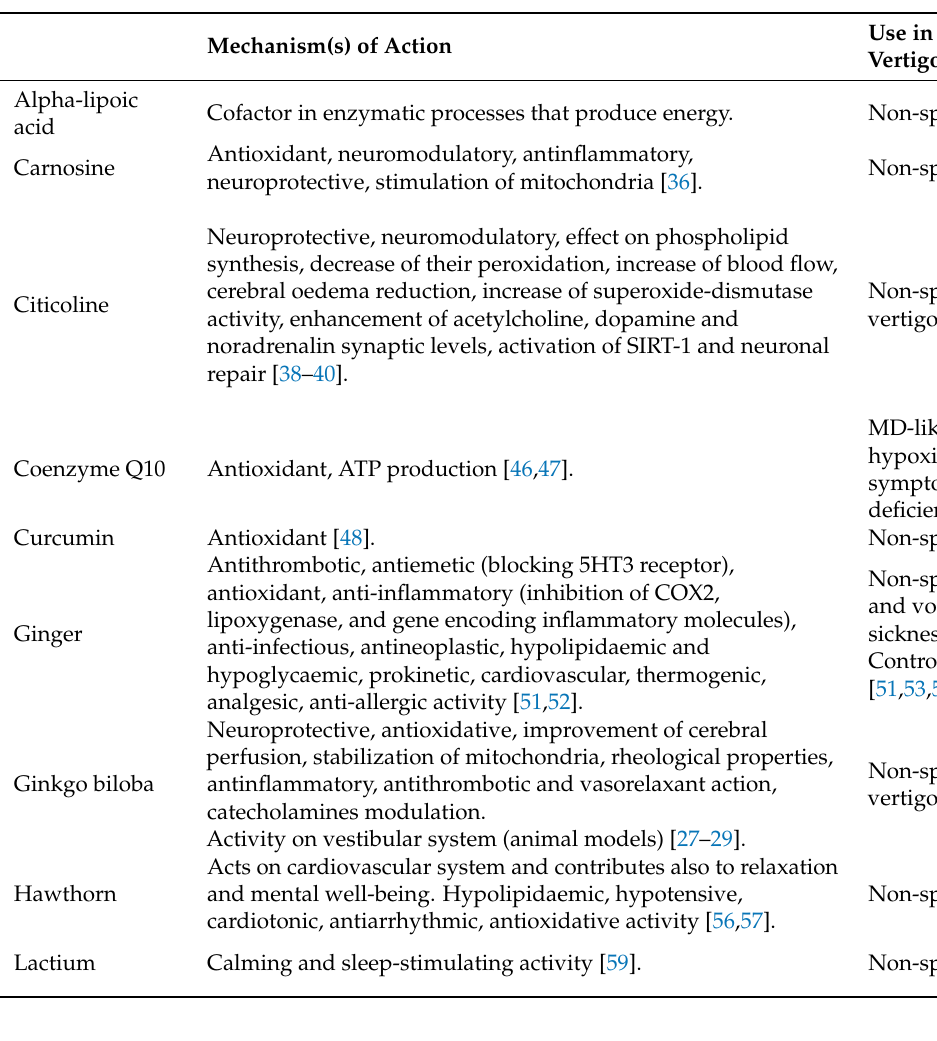
Table 2. Mechanism of action and adverse events of the main nutraceuticals/supplements used in peripheral vestibular